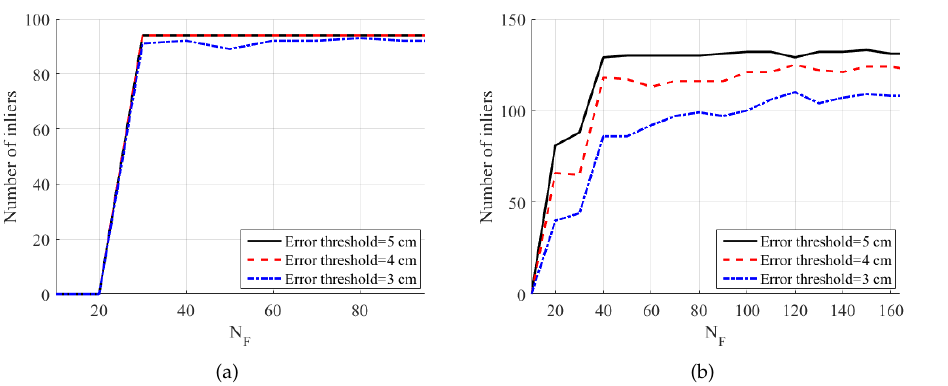
Figure 17. Number of inliers according to the number of sphere centers N F used for extrinsic calibration (proposed method). The figures show the number of triples of corresponding sphere centers whose maximum pairwise distance is less than the error threshold. ( a ) Static set ( N = 95). ( b ) Dynamic set ( N = 164). Refer to the text for more detail. Best viewed in